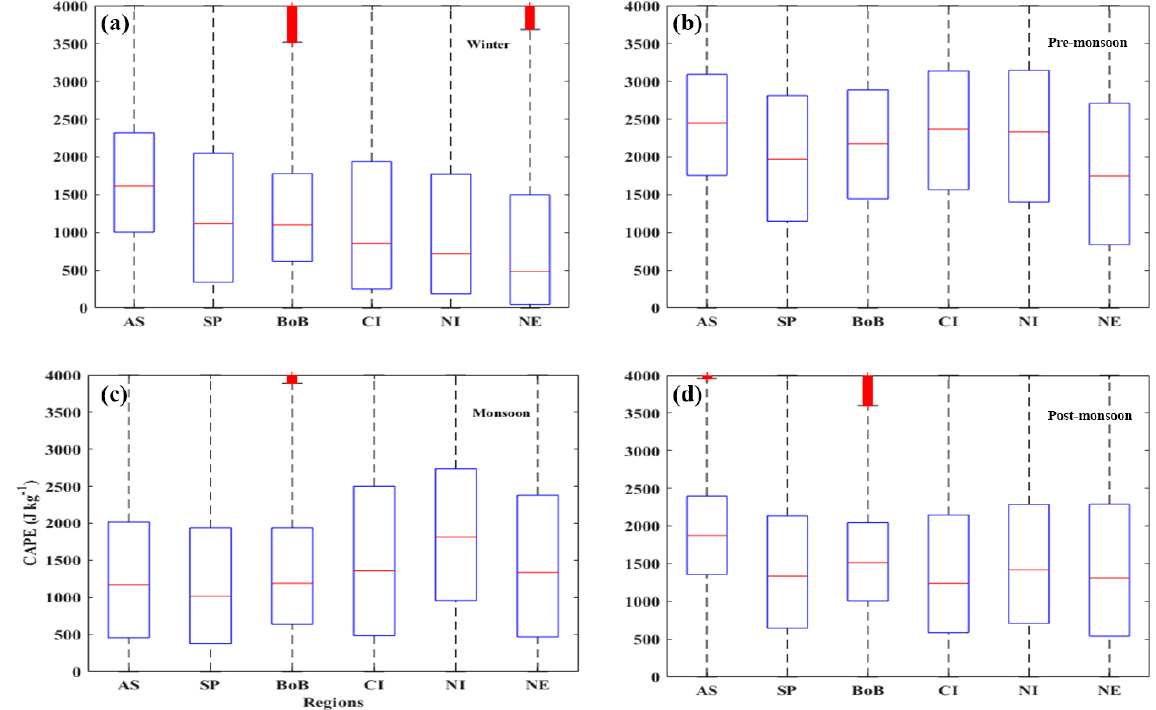
Figure 10. Box-plot analysis of CAPE (Jkg − 1 ) during (a) winter, (b) pre-monsoon, (c) monsoon, and (d) post-monsoon from INSAT-3D data of six sub-regions over the Indian